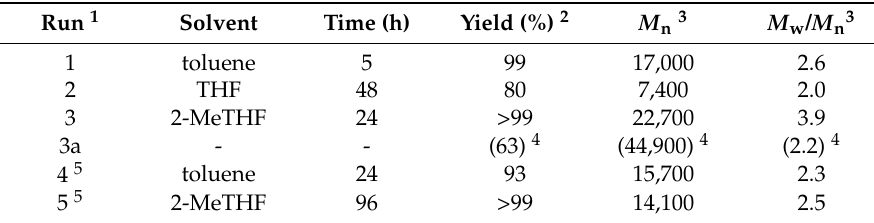
Table 1. DArP of 1-Br and 2-H .